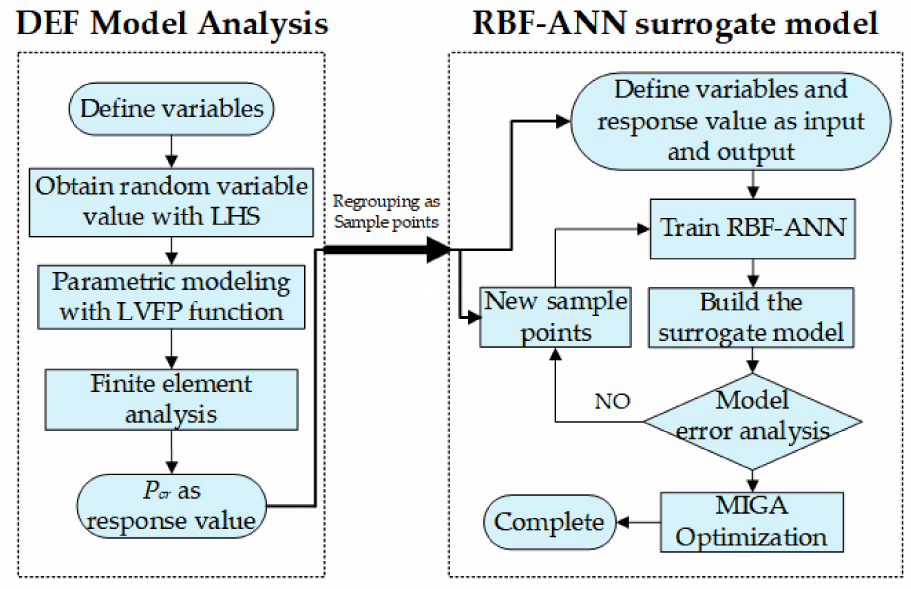
Figure 3. Flow chart of design and optimization